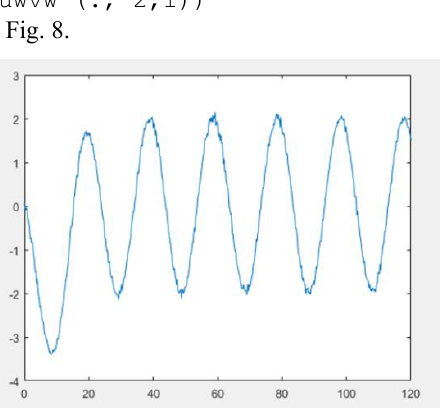
Fig. 8 . Model with process noise and observation noise when applying harmonic input